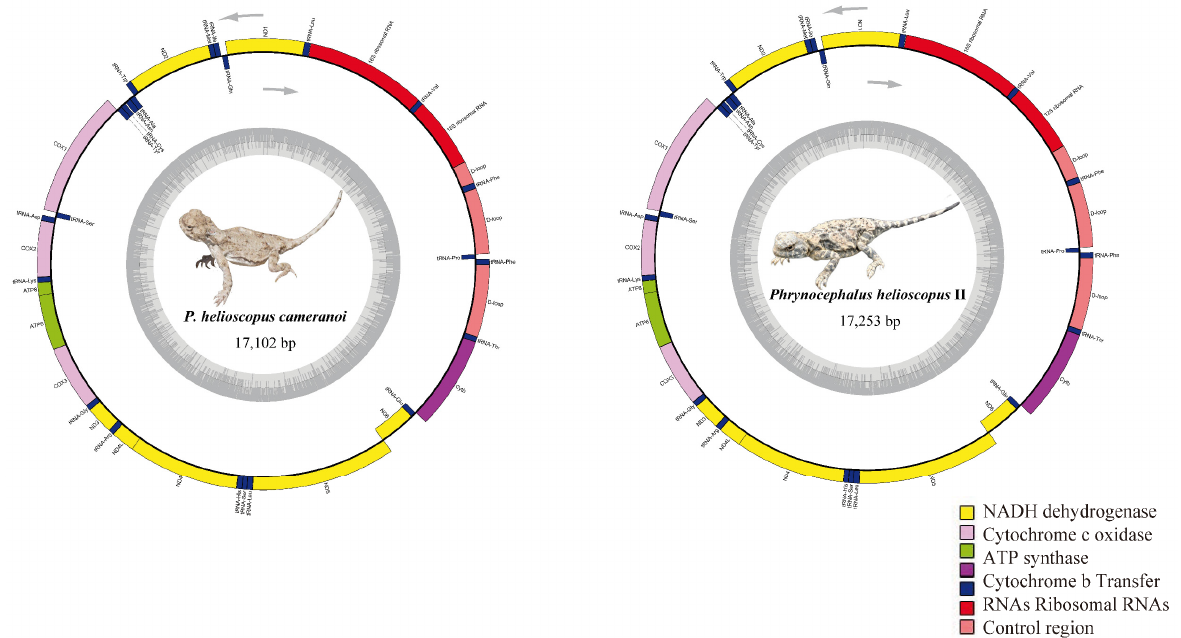
Figure 2. Mitochondrial genome map of P. helioscopus cameranoi and P. helioscopus varius II . Genes encoded on the heavy or light strand are indicated on the outside or inside of the circular mitogenome map, respectively, showing the direction of transcription. The tRNAs are denoted by color and labeled according to the three-letter amino acid codes. Lizard photos were taken by Jinlong Liu.